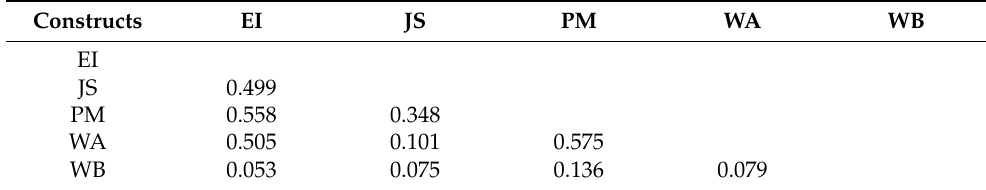
Table 3. Results of discriminant validity by HTMT.